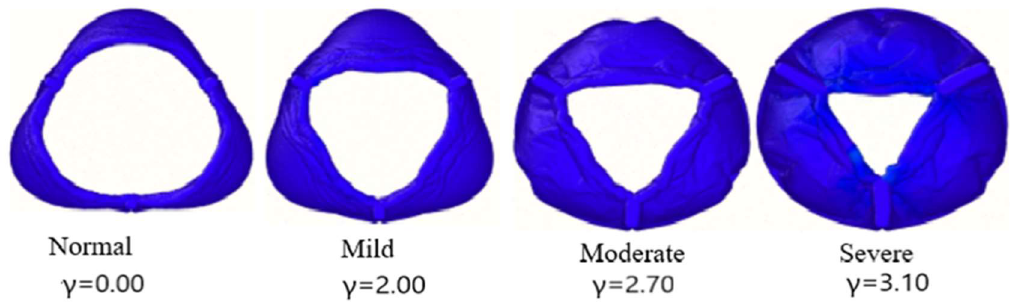
Figure 3. Severity of aortic valve stenosis in terms of orifice opening (stenosis).